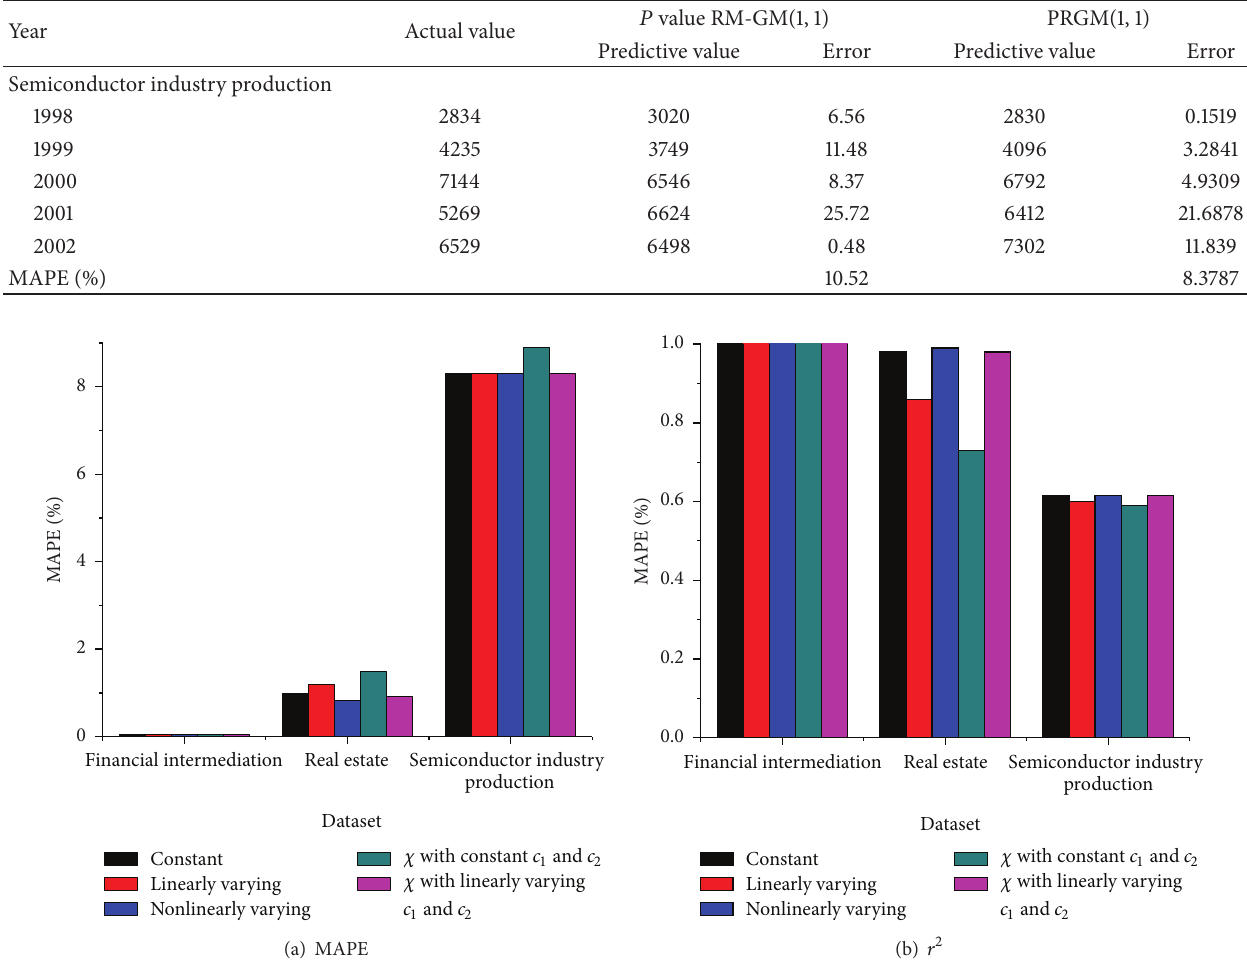
Table 4: The forecasting data and evaluation metrics produced by PRGM(1, 1) and 𝑃 value RM-GM(1, 1).